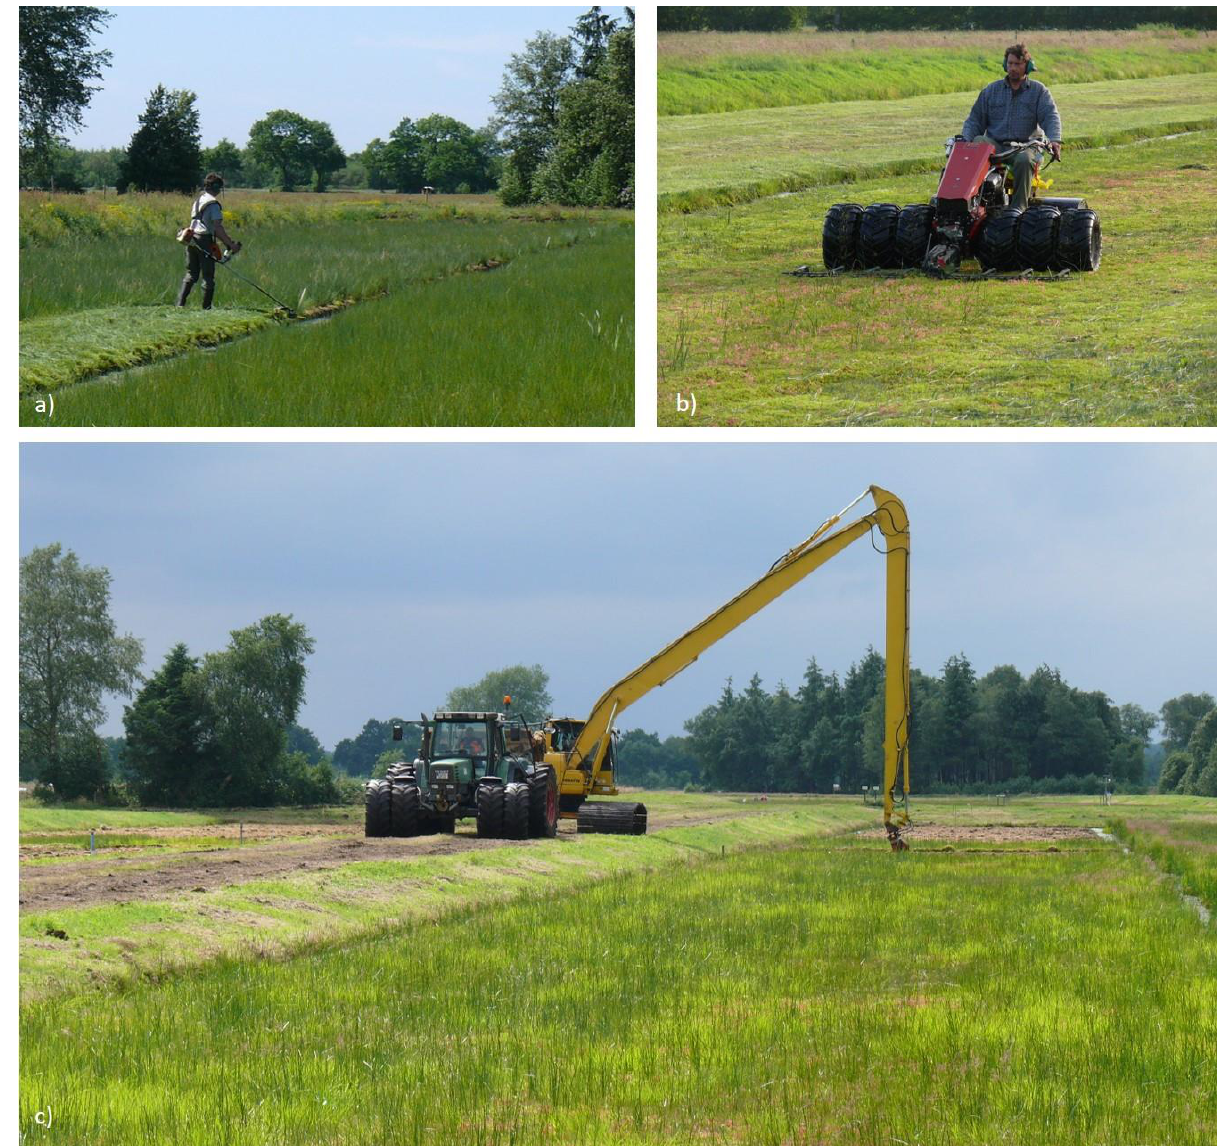
Figure 6. Weed management at the Rastede Sphagnum farming site using: a) brush cutter / strimmer; b) single-axle mower with cutter bar and triple tyres; c) excavator equipped with an extra-long arm and a mowing bucket, operating from a causeway. Photos: Sabine